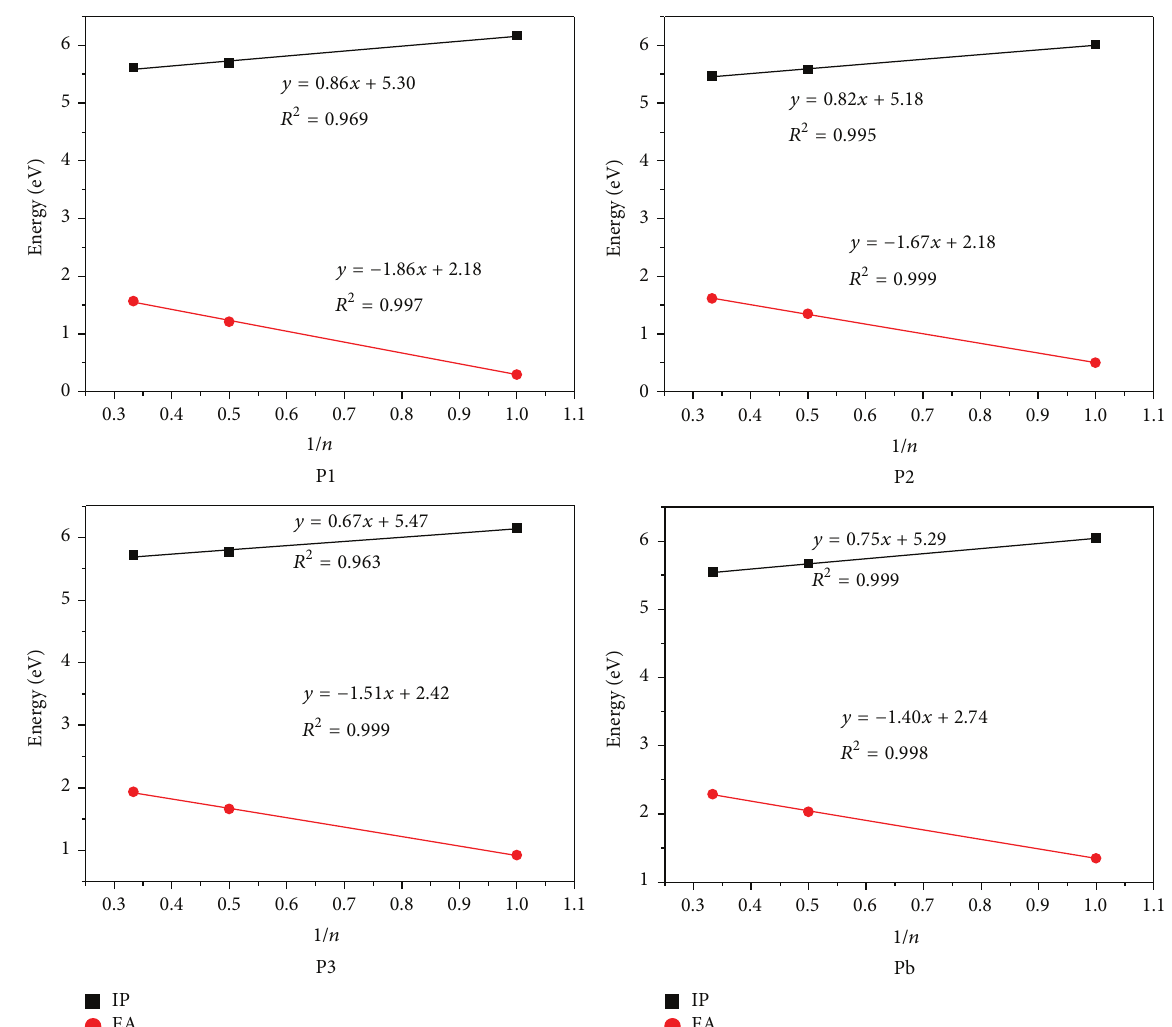
Figure 4: The relationship between ionization potentials (IP) and electron affinities (EA) of P1, P2, P3, and PBDT-BTA (Pb) and the reciprocal of conjugated unit ( 1/𝑛